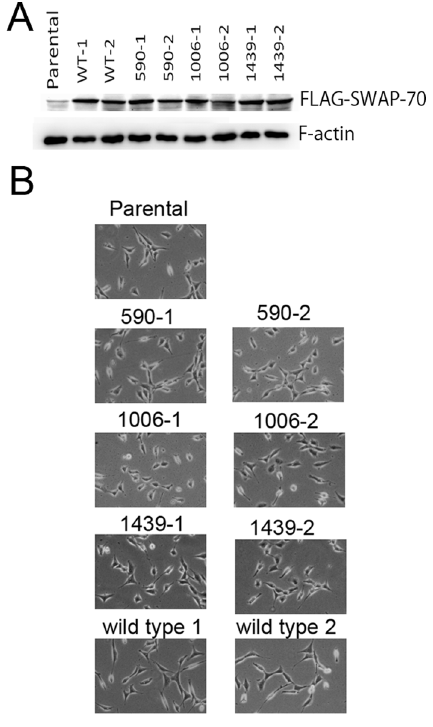
Figure 2. Expression of mutant SWAP70 s and morphology of the transfectants. A, Expression of FLAG-tagged SWAP-70 was detected by Western blotting with an anti-FLAG antibody. B, Morphology of the transfectants. The cells expressing mutant SWAP- 70 s were slightly shorter than the parental or the wild-type SWAP-70- expressing